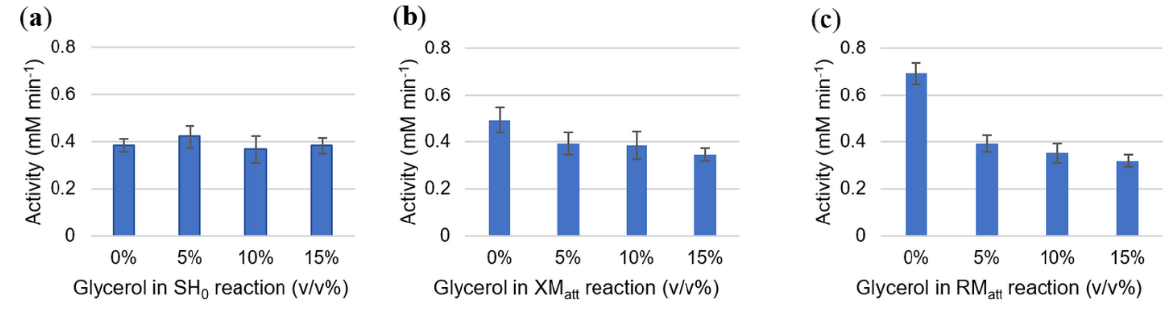
Figure 7. Comparison of the effective activity of AAL-MNPs in various agitation modes at different viscosities. The effective activity values of AAL-MNPs are shown in ( a ) the shake vial mode (SH 0 at 650 rpm), in ( b ) the axial agitation mode (XM att at 160 mpm), and in ( c ) the rotating agitation mode (RM att at 120 rpm) at various viscosities of the reaction media (altered by adding 5%, 10%, and 15% glycerol to the reaction